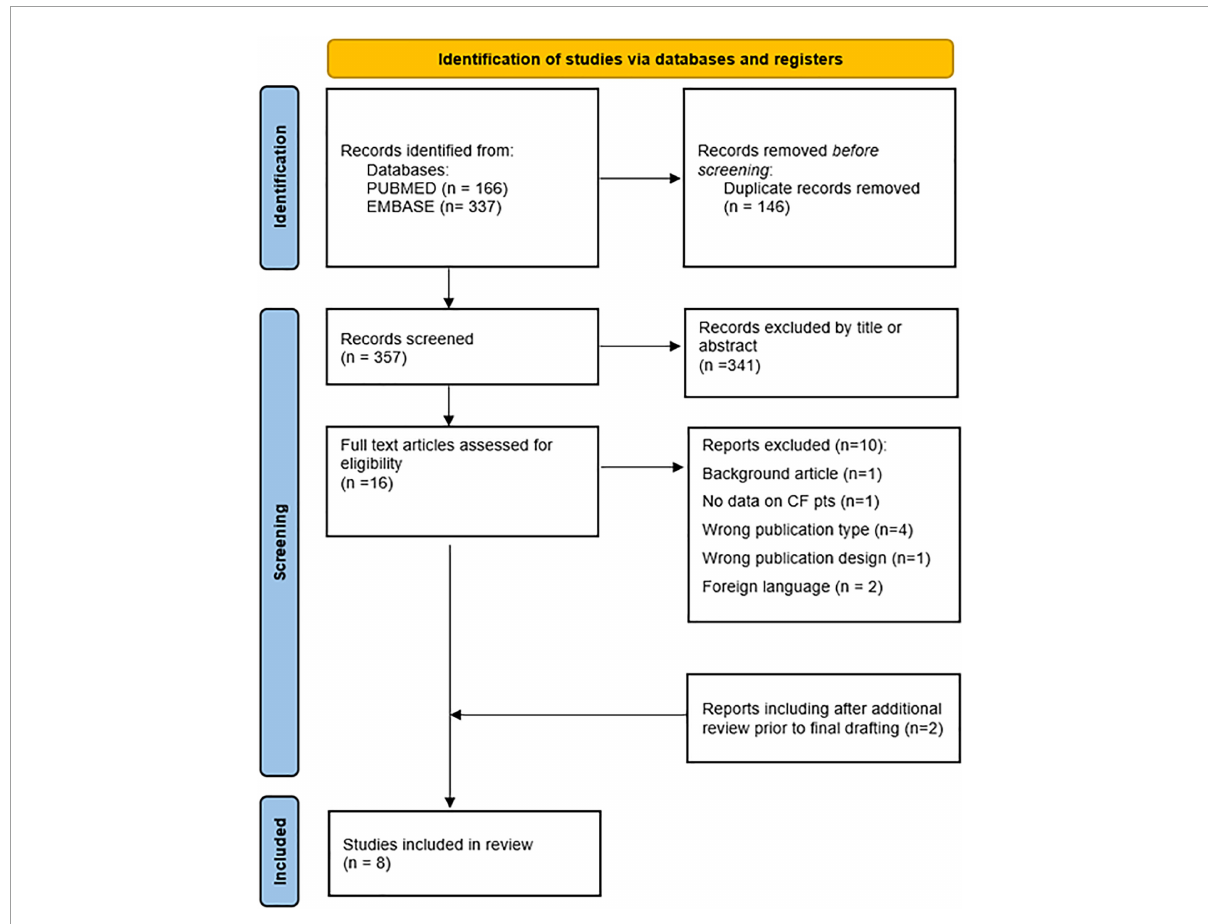
FIGURE2 PRISMA flow diagram for literature research and data